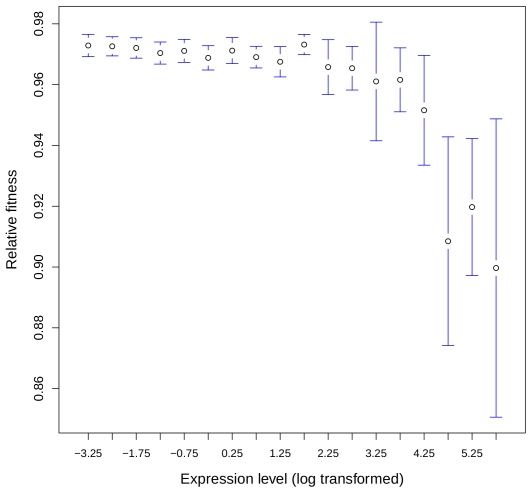
Relationship between gene expression level and loss of fitness associated to heterozygous KO in yeast.The fitness after deletion of one allele in yeast was taken as the minimal fitness measured across all conditions given in [25]. Genes were binned according to their expression level (expression data from [26], see Materials and Methods) and the average fitness computed for each bin. The 18 bins analyzed contained a total of 5,030 genes. Error bars correspond to the 95% confidence interval.